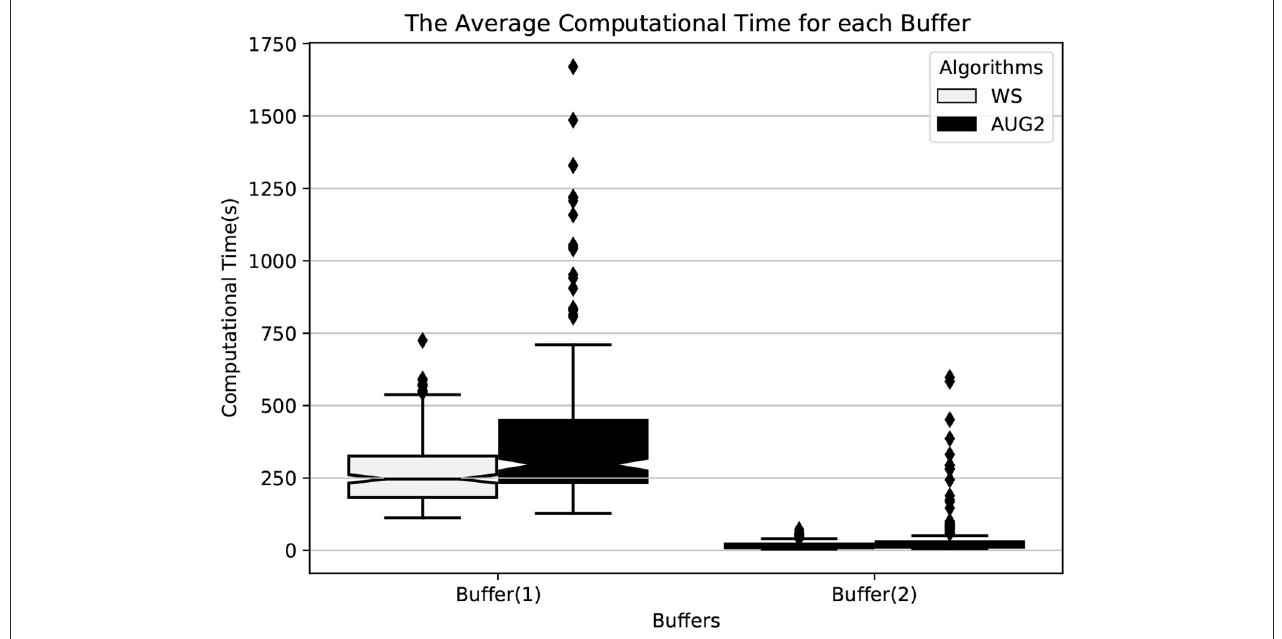
FIGURE 13 | Average time of all configurations for each